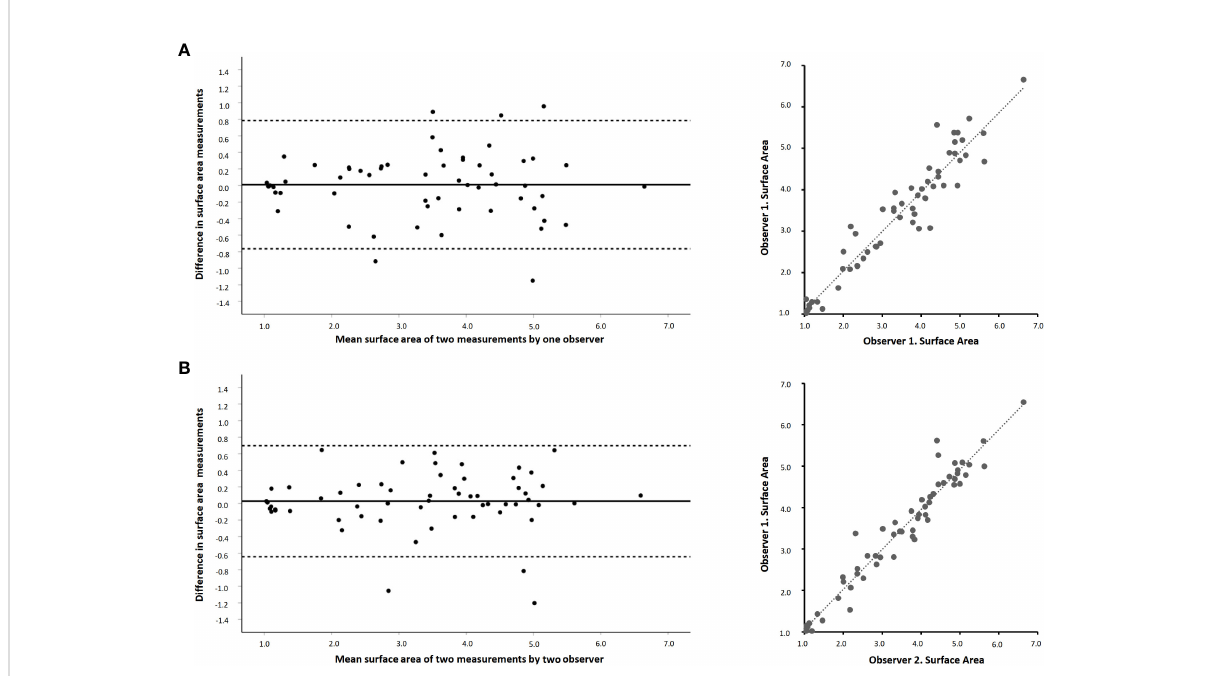
FIGURE 3 Bland – Altman plots and linear regressions of the surface area measurements of duodenal mucosa with micro-CT imaging by two blinded readers. The panels show the surface area values between intraobserver (A) and interobserver (B) measurements. The x-axis in Bland – Altman shows the mean of the measurements and y-axis the differences between the measurements. Solid horizontal lines denote the average difference between the readers and dotted lines 95% limits of agreement. The surface area values are given in relation to a theoretical completely fl at area with a value of 1.0.